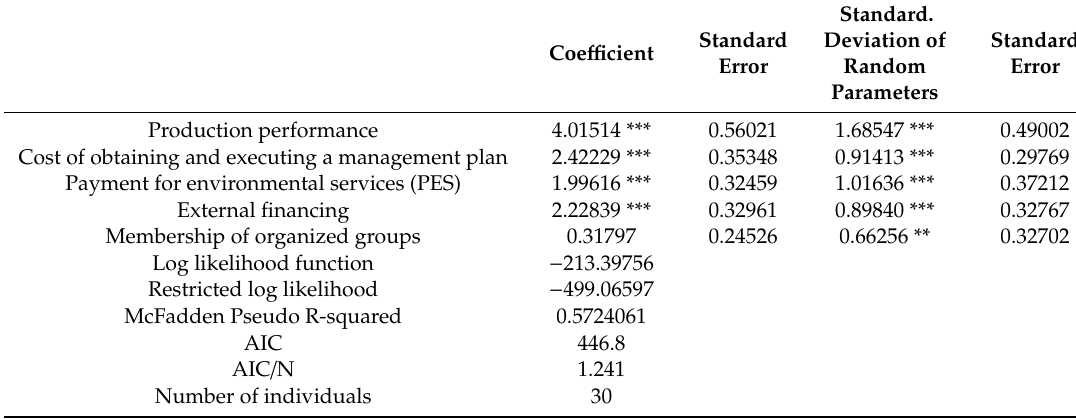
Table 3. Results from the estimation of the Random Parameters Logit Model, for the most critical risk elements for sustainability of a managed forest unit in the North Zone of Costa Rica–Round